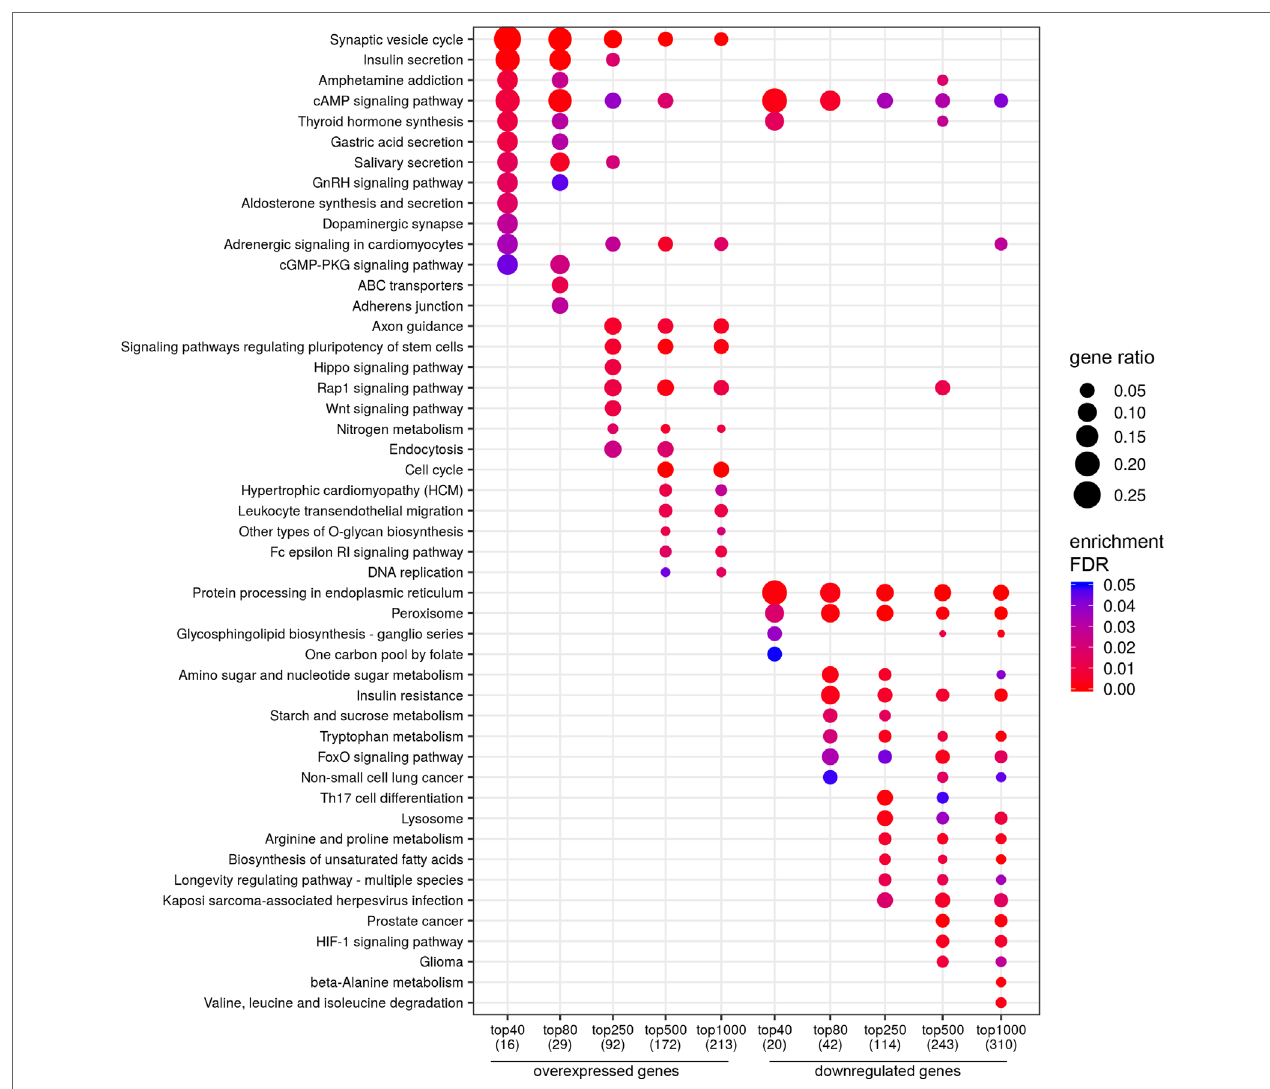
FIGURE 2 | Dotplot showing the results of KEGG pathways enrichment analyses performed for top-40, 80, 250, 500, and 1,000 differentially expressed genes (either overexpressed or downregulated) between the groups of adverse and favorable prognosis (TCGA data). All the genes have passed the following thresholds: DESeq p -value < 0.01, Mann–Whitney p -value < 0.05, average expression-level fold change > 25%. Dot size indicates k / n ratio (“gene ratio”), where k is the number of genes participating in the current KEGG pathway (within top-40, top-80, or other top lists), and n is the number of genes (also within top-40, top-80, or other top lists) annotated as participants of any KEGG pathway (these numbers are provided in the brackets in the bottom of the figure). Dot color indicates the enrichment test FDR (Fisher’s exact test).